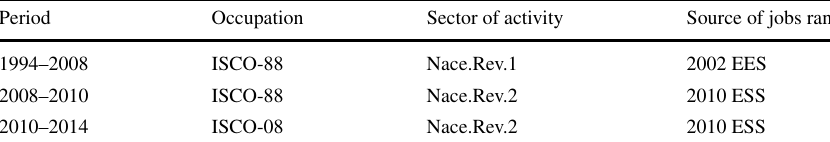
Table 13 Period of analysis, main classifications and databases to be